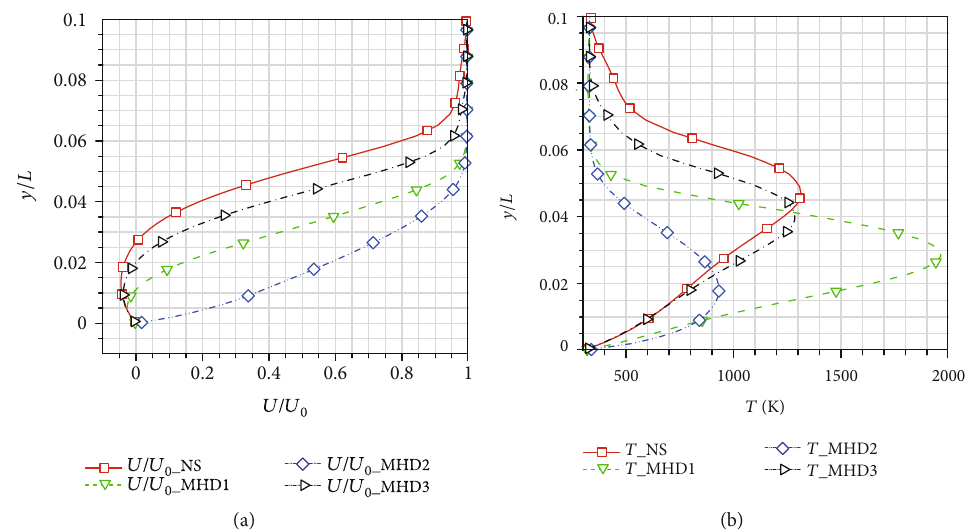
Figure 13: Velocity and temperature pro fi les near the corner at x / L = 0 : 9 under di ff erent interaction region locations: (a) pro fi les of velocities; (b) pro fi les of temperatures.